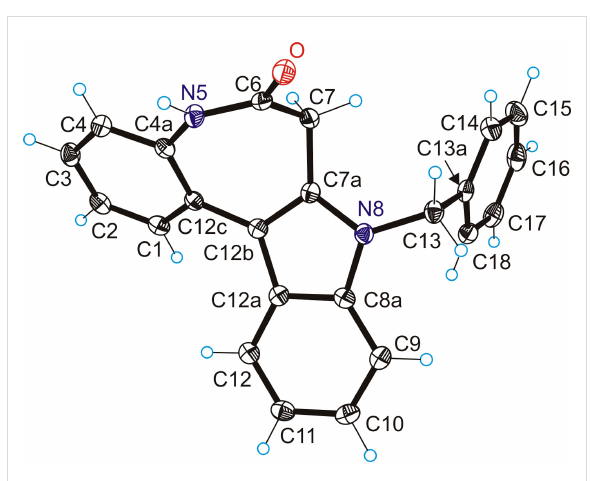
Figure 3: ORTEP view of 3a with thermal ellipsoids drawn at the 50% probability level.